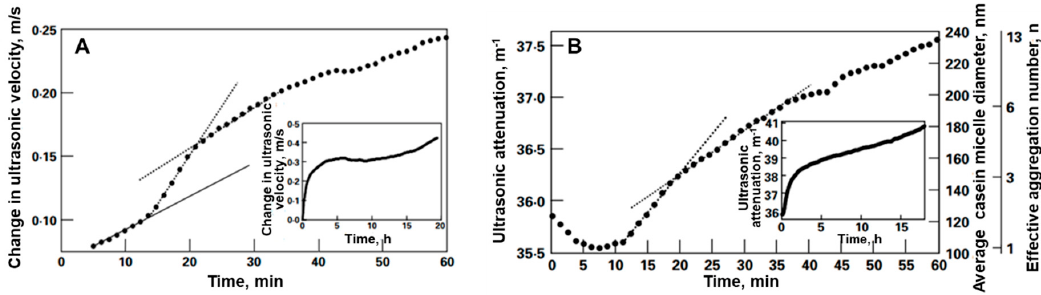
Figure 11. Ultrasonic profiles, measured at 14.5 MHz, of the renneting process of milk at 30 °C. ( A ) Changes in the ultrasonic velocity during the first 60 min of the renneting of the milk samples. The slopes drawn mark each region of the process. The insert presents the whole time scale of the measurements. ( B ) The corresponding ultrasonic attenuation profile showing the effects of the process. The insert presents the whole time scale of the process. Reproduced with permission of Cambridge University Press from Dwyer et al. [113].